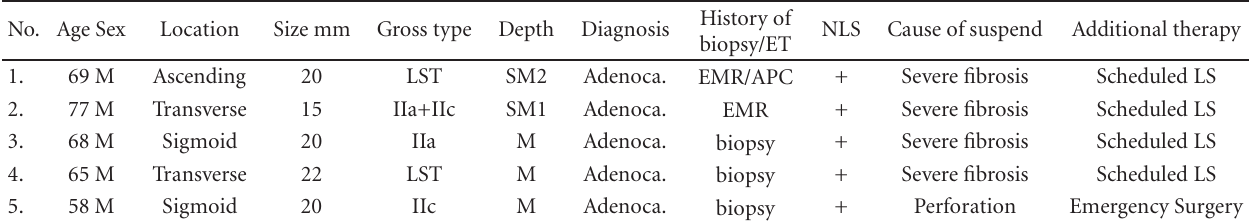
Figure 2: A case of ESD failure. (a) Residual mucosal lesion after EMR located in the hepatic flexure of the colon. (b) Non-lifting sign was positive after submucosal injection. (c) Submucosal layer was clearly visualized after incision. (d) Severe submucosal fibrosis existed under the lesion. ESD procedure was suspended to avoid perforation. Table 2: Clinicopathologic characteristics of 5 suspended